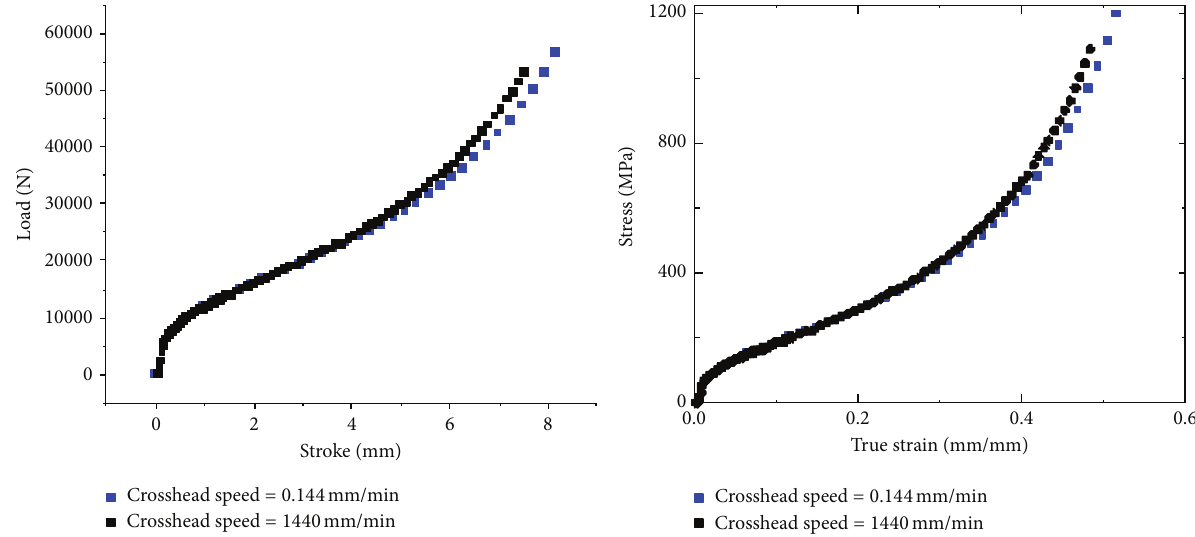
Figure 4: Curves load versus stroke and true stress versus true strain of the alloy Al6060 under heat treated conditions and solubilized homogenate used in all simulations with the finite element method ECAP